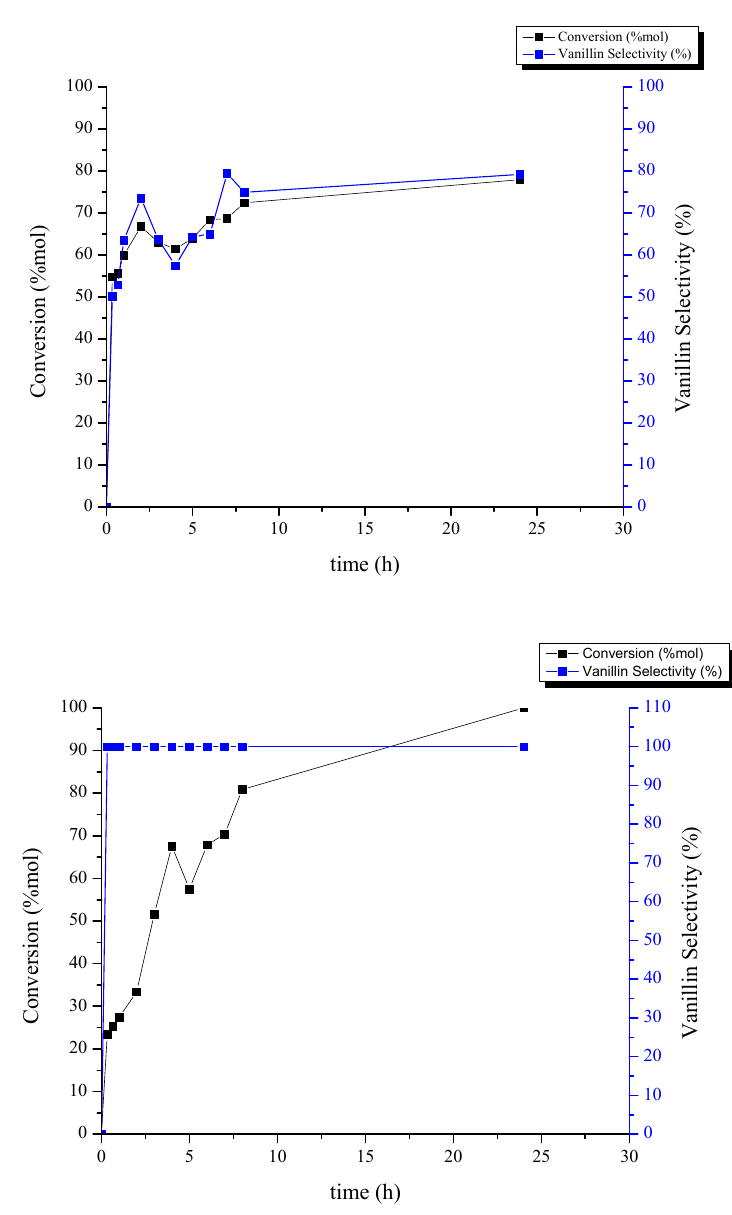
Figure 8. Catalytic activity at 90 °C of CuO/MgAl 2 O 4 catalyst in the oxidation of isoeugenol to vanillin ( top image ) and CuO/MgAl 2 O 4 catalyst in the oxidation of vanillyl alcohol to vanillin ( bottom image ).